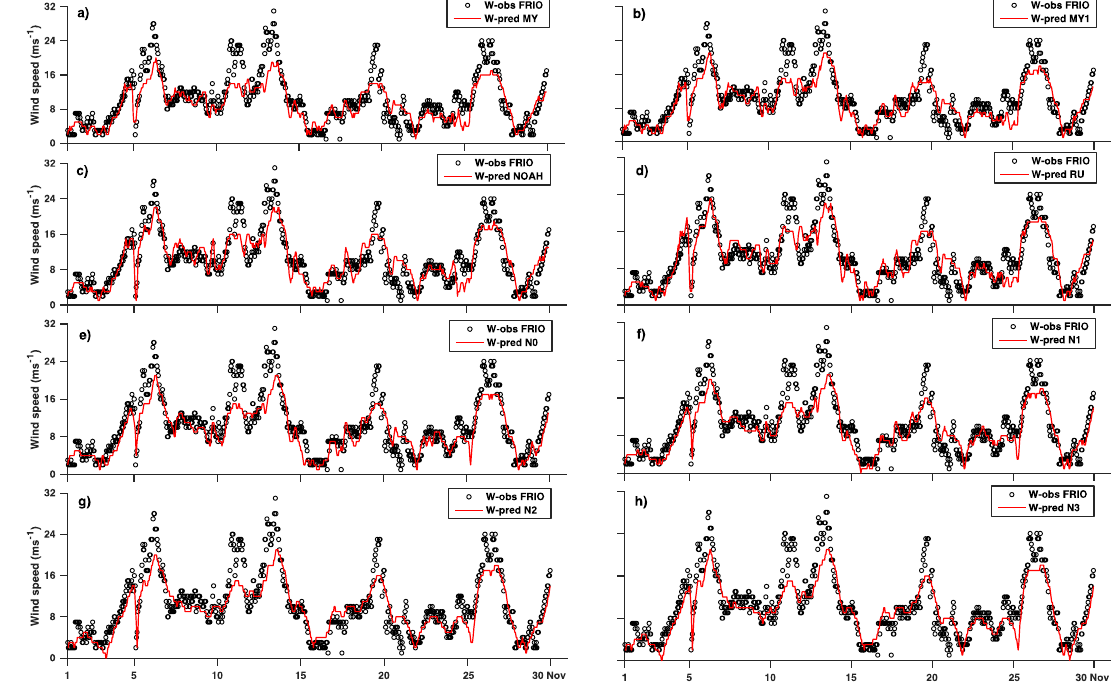
Figure 11. Time series of wind speed observed at FRIO meteorological station versus wind speed predicted by MY ( a ), MY1 ( b ), NOAH ( c ), RU ( d ), N0 ( e ), N1 ( f ), N2 ( g ), and N3 ( h ) simulations. Atmosphere 2020 , 11 , x FOR PEER REVIEW 16 of 22